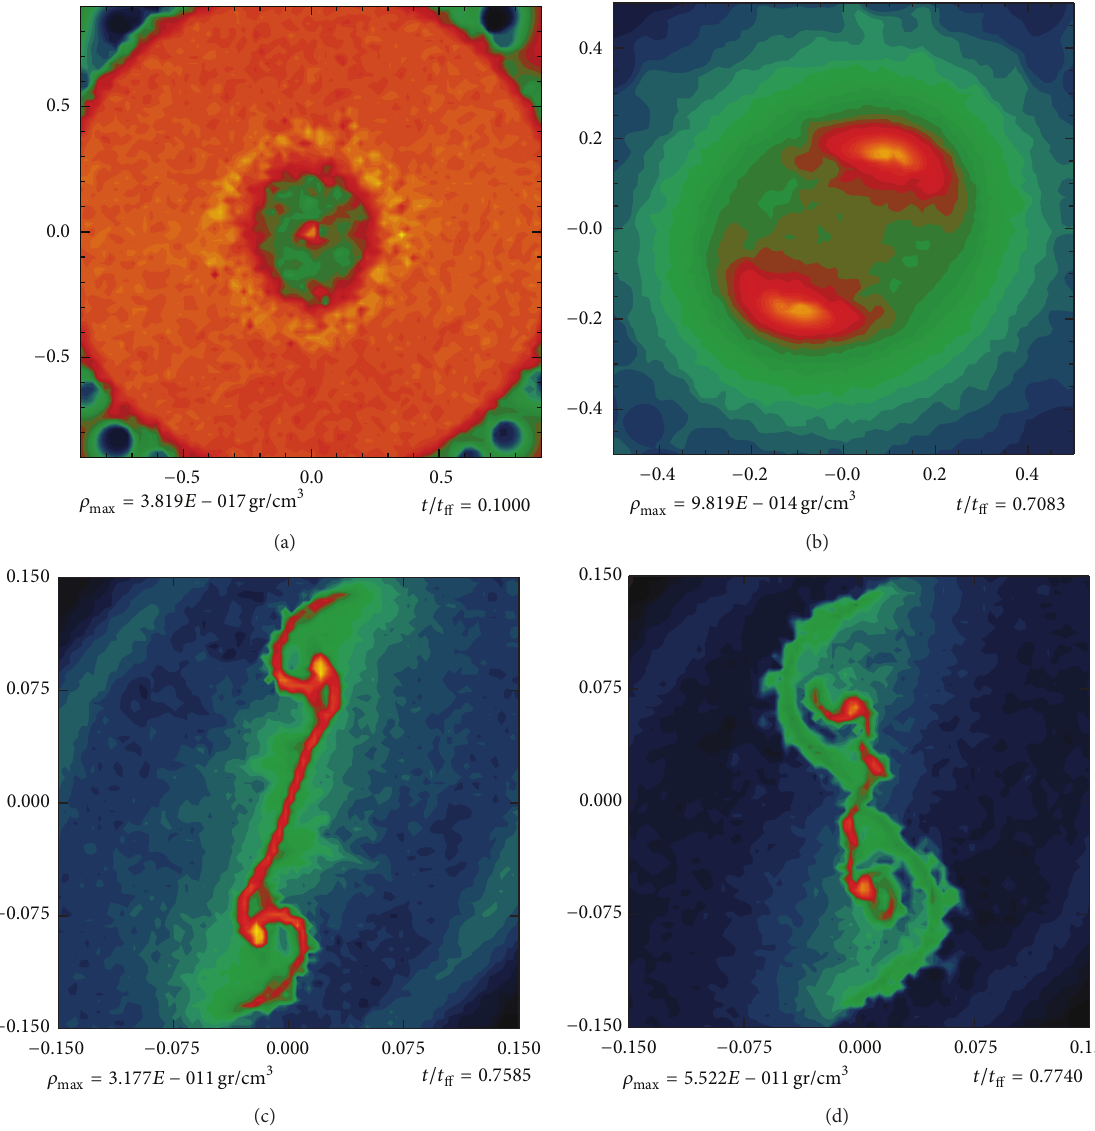
Figure 17: Iso-density plots for a thin slice of matter parallel to 𝑥𝑦 plane for the higher-resolution test run. A comparison between the R2Om2 model shown in Figure 13 and this plot demonstrates that convergence is